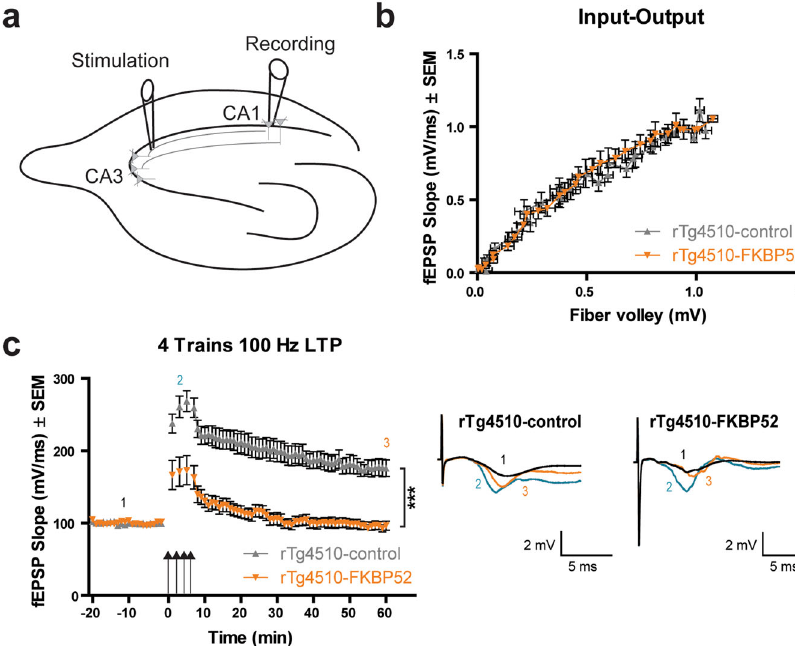
Fig. 5 FKBP52 overexpression induces de fi cits in hippocampal LTP. a Schematic of the long-term potentiation (LTP) protocol in ex vivo hippocampal slices from rTg4510 mice infused with AAV9-control or AAV9-FKBP52. Stimulating electrode was positioned in the Schaffer collaterals (between CA3 and CA1) and recordings were obtained in the CA1 pyramidal neurons. b Input – Output (I – O) curve to evaluate pre- and postsynaptic excitatory function. The I – O curve compares the fEPSP slope (mV/ms) versus the fi ber volley amplitude (mV). c Four-trains of high-frequency stimulation (HFS) at 100 Hz were given to induce LTP (indicated by the arrows). Following this, fi eld EPSPs were measured for 60 min. Representative traces are shown on the right. Signi fi cance was determined by repeated measures two-way ANOVA (*** p < 0.001). Data are shown in standard error of the mean (±SEM). n = 23 for rTg4510-control and n = 12 for rTg4510-FKBP52. Representative traces are shown as 1 (black) indicates baseline, 2 (teal) indicates initial early LTP in the fi rst minute following HFS, and 3 (orange) indicates late LTP in the last 60 min of recording. fEPSP fi eld excitatory postsynaptic potential, min minutes, CA1 CA3 Cornu Ammonis 1, 3, LTP long-term potentiation, mV millivolts, ms milliseconds, Hz